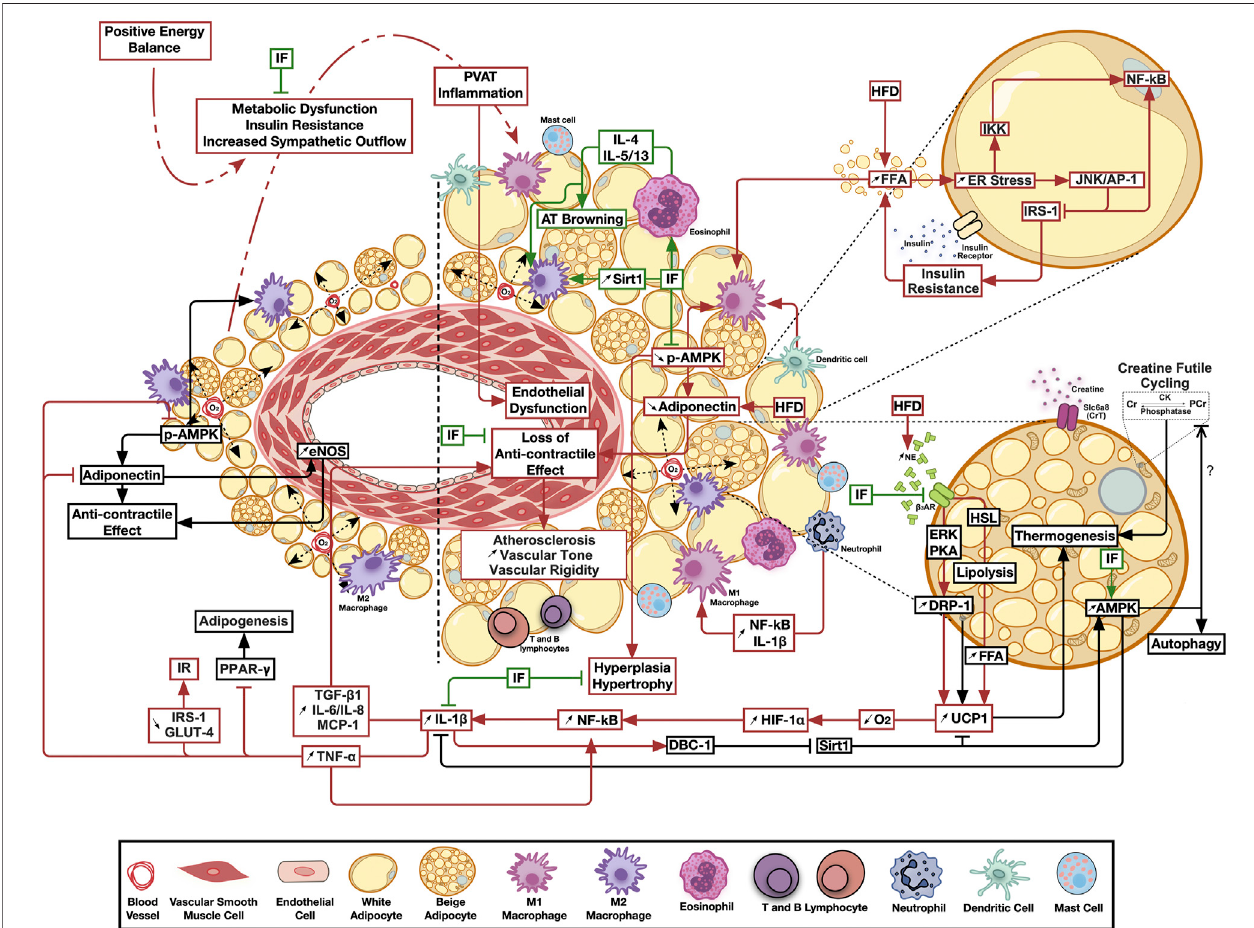
FIGURE 1 | The emerging ameliorative role of intermittent fasting on perivascular adipose tissue in fl ammation and thermogenesis. Calorie excess resulting in metabolic dysfunction triggers perivascular adipose tissue chronic low-grade in fl ammation, leading to the loss of its anticontractile effects and the subsequent negative paracrine modulation of vascular structure and function. Intermittent fasting ameliorates in fl ammatory, thermogenic and bioenergetic pathways favoring adipose tissue homeostasis. Pathways involved in adipose tissue homeostasis are shown in black, those activated by metabolic dysfunction in red, while those modulated by intermittent fasting in green arrows. AT, Adipose tissue; AMPK, AMP-activated protein kinase; β 3 AR, Beta 3 adrenergic receptor; CK, Creatine kinase; Cr, Creatine; DBC-1, Deleted in bladder cancer protein 1; DRP-1, Dynamin related protein 1; eNOS, Endothelial nitric oxide synthase; ER, Endoplasmic reticulum; ERK, Extracellular signal-regulated kinase; FFA, Free fatty acids; HFD, High fat diet; HIF-1 α , Hypoxia-inducible factor 1-alpha; HSL, Hormone sensitive lipase; IF, Intermittent fasting; IKK, IK β kinase; IL, Interleukin; IRS-1, insulin receptor substrate 1; JNK/AP-1, c-jun N-terminal kinase/activator protein 1; MCP-1, Monocyte Chemoattractant protein 1; NE, Norepinephrine; NF- κ B,Nuclearfactorkappa B;O 2 ,Oxygen;PVAT,Perivascularadipose tissue;PCr, Phosphocreatine;PKA,ProteinkinaseA;Sirt1,Sirtuin1;TGF- β 1, Transforming growth factor beta 1; TNF- α , Tumor necrosis factor alpha; UCP1, Uncoupling protein